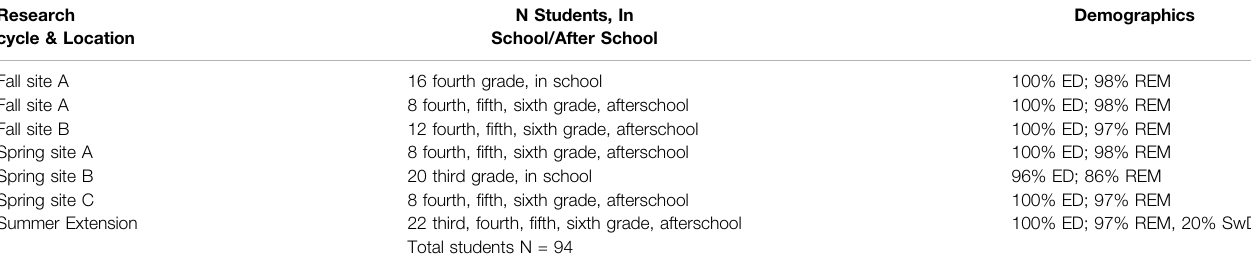
ED, Economically Disadvantaged; REM, Race/Ethnic Minorities; SwD, Students with